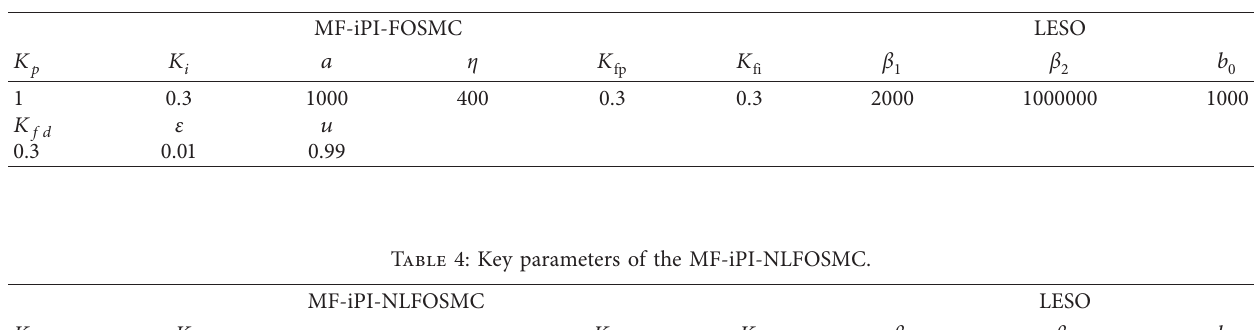
Table 3: Key parameters of the MF-iPI-FOSMC.